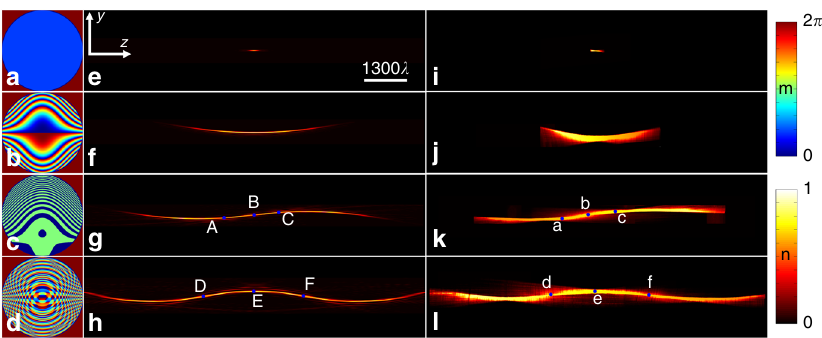
Fig. 2 UAD light beams with different number of energy oscillations under the condition of NA = 0.095. e Zero oscillations, f one oscillation, g two oscillations, and h three oscillations are generated by the phases ( a – d ), the parameters of which can be found in Table 1. The anti-diffracting distances in the experiment are approximately 204.1 λ , 2544.9 λ , 5606.2 λ , and 8316.1 λ ( i – l ), and their corresponding theoretical results ( e – h ) are 195.7 λ , 2560 λ , 5592 λ , and 8310 λ , respectively. A – F are the points on the UAD light beams, wherein B, D, F are the switch points. a – f are their corresponding points in the experiment. All light intensities of UAD light beams are normalized to a unit value, which are indicated by the color bar ( m ). The color bar ( n ) shows the phase scale of a – d